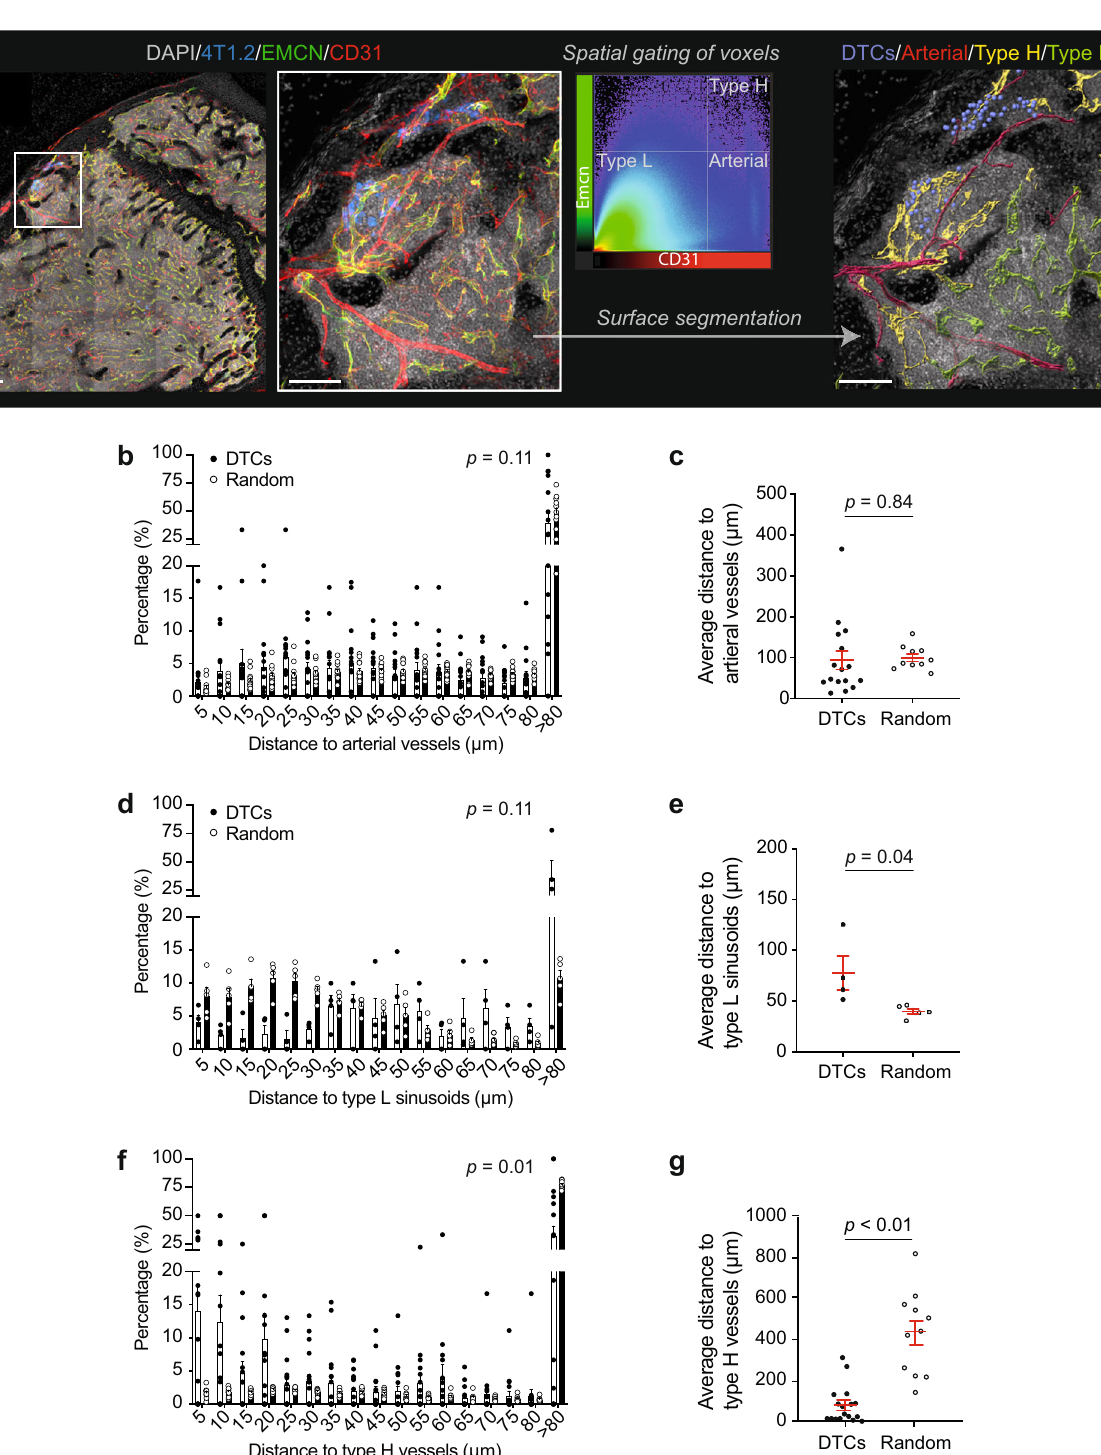
Fig. 2 A specialised vascular niche for mammary cancer cells during bone colonisation. a 3D confocal image of DTCs (blue) in bone marrow. Bones were stained for DAPI (grey), EMCN (green) and CD31 (red). The image was transformed into a density plot that displayed voxel intensities in the CD31 and EMCN channels. Spatial gates were drawn to split the data set into phenotypically distinct components for volumetric reconstructions. Arterial vessels were de fi ned by CD31 hi EMCN – (red); Type H capillaries by CD31 hi EMCN hi (yellow); Type L sinusoids by CD31 lo EMCN lo (green) ( n = 4 mice). Scale bars: 100 µ m. b , d , f Distance to the nearest arterial vessel ( b ), type L sinusoid ( d ) and type H vessel ( f ) of individual DTCs and random spots were binned in histogram format. c , e , g Bar charts showing the averages of distances to vessel subtypes. Individual dots are from metastases from different mice. A total of 1256 DTCs ( b , c ), 299 DTCs ( d , e ) and 1052 DTCs ( f , g ) were analysed in 16 ( b , c ), 4 ( d , e ) and 17 ( f , g ) mice, respectively. P values in ( b ), ( d ), ( f ) by two-sided Kolmogorov − Smirnov analysis, and in ( c ), ( e ), ( g ) by two-tailed unpaired t tests. All data re fl ect mean ± s.e.m. Source data are provided as a Source Data fi